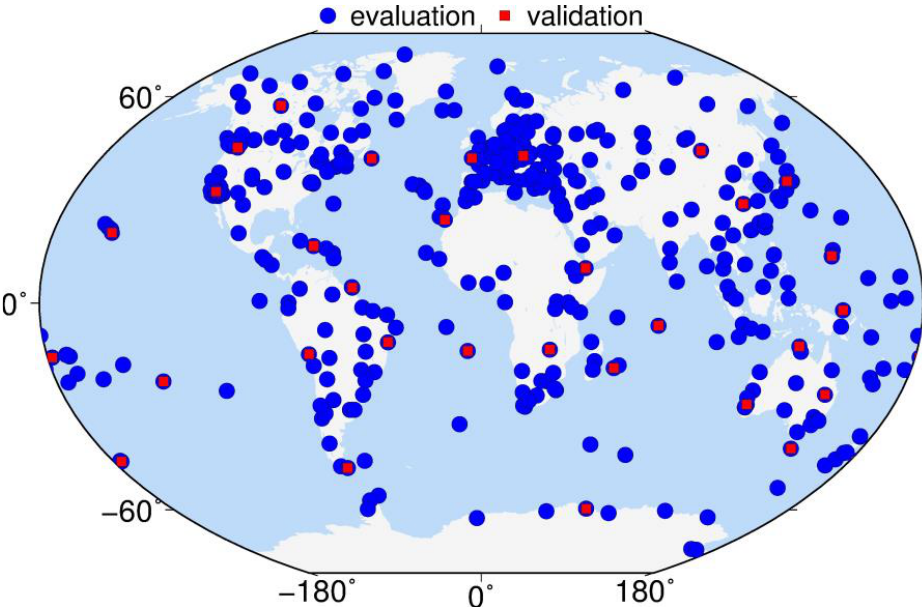
Figure 5. Distribution of the selected model evaluation (blue circles) and positioning validation (red squares) stations.